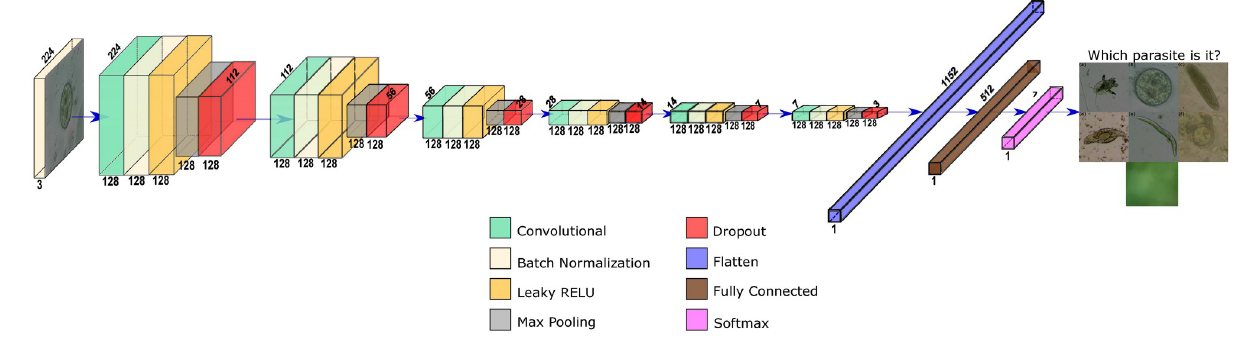
Fig 7. Custom CNN for C = 6 blocks and F = 128